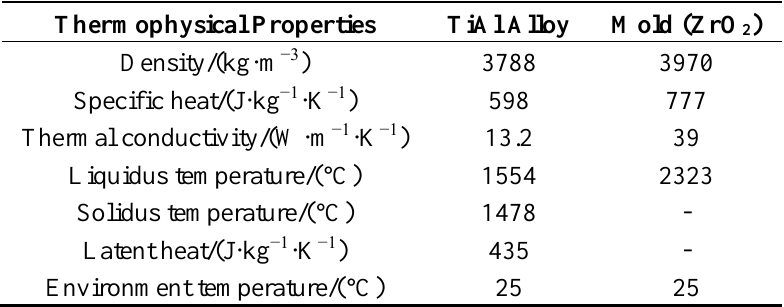
Table 2. Thermo-physical properties of TiAl alloy and ZrO 2